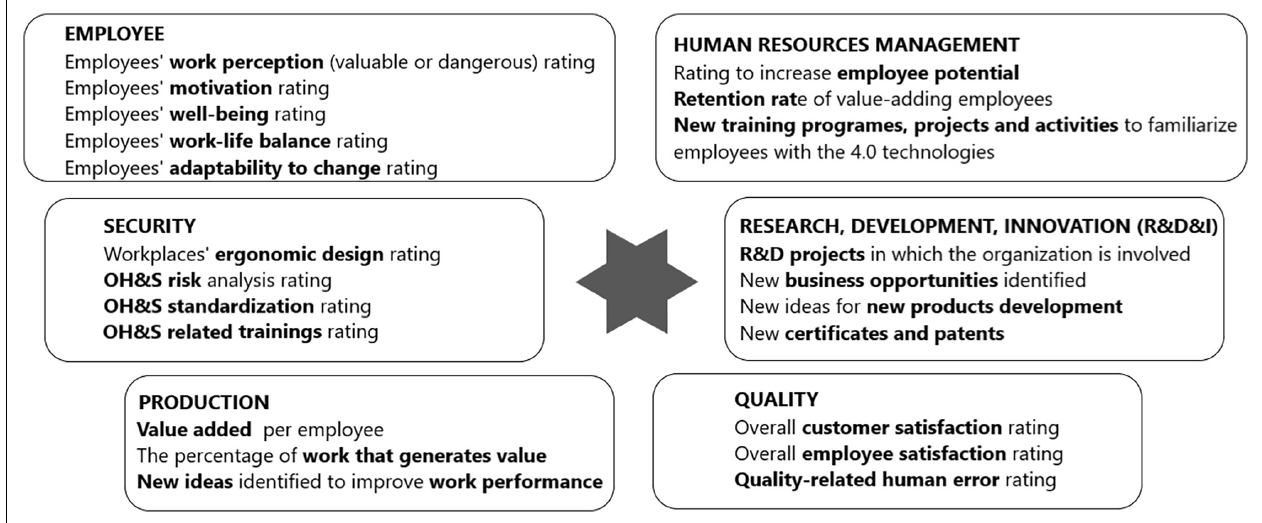
FIGURE 4 | The human capital valorization (HCV) monitoring